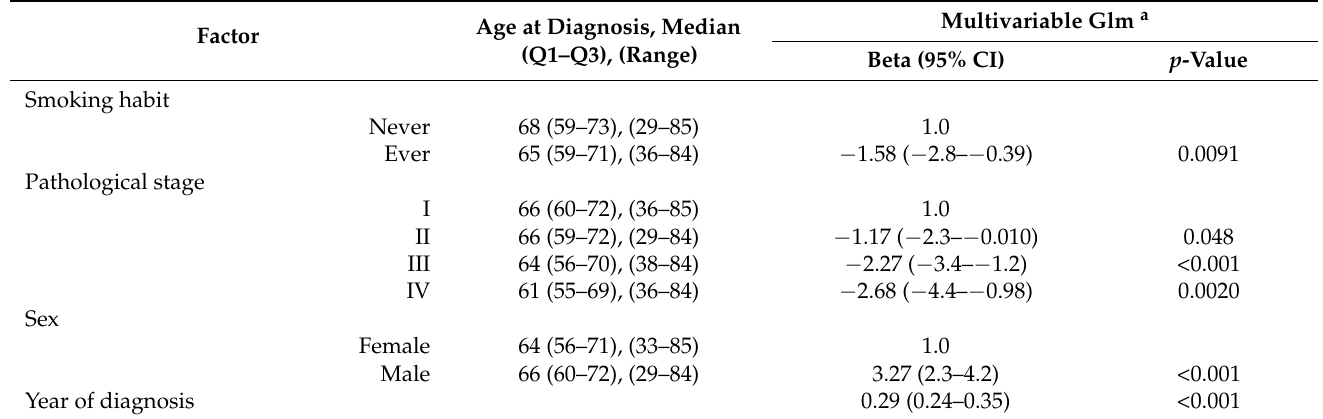
Table 2. Discovery series: association of age at diagnosis of lung adenocarcinoma with smoking habit, pathological stage, sex, and year of diagnosis in 1694 patients.